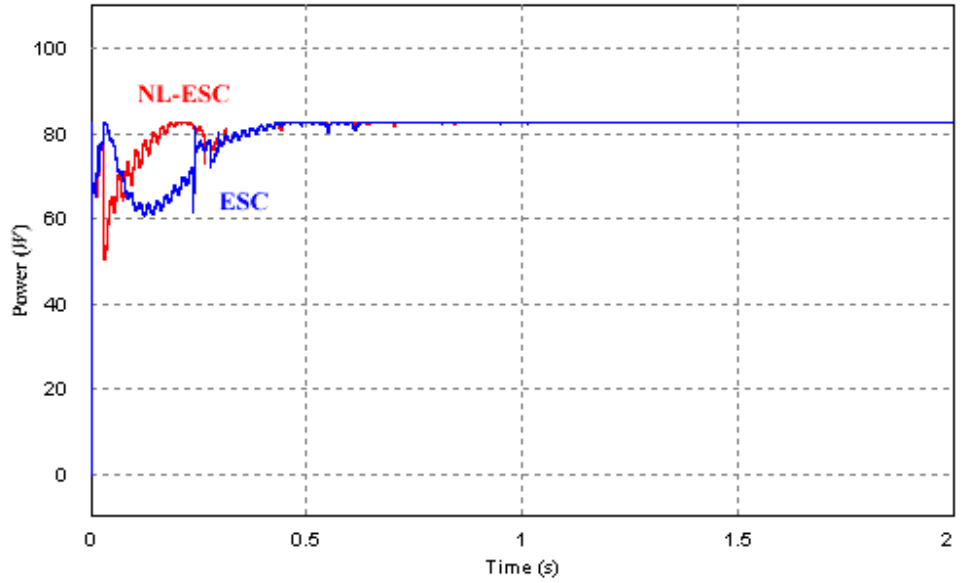
= 0.15 in NL-ESC case ( Red ); i = 0.15in ESC case ( Blue i